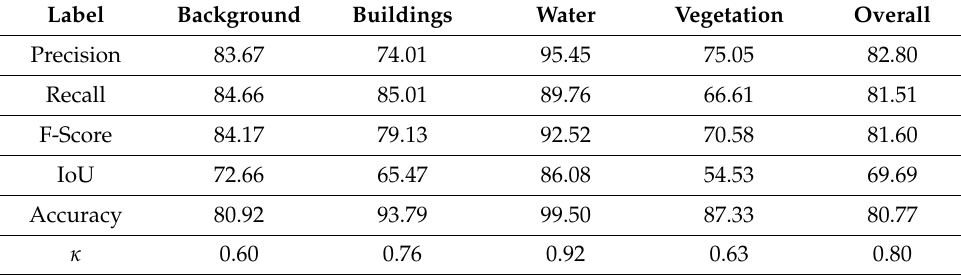
Figure 8. Visual results of our Bayesian U-Net on the Toulouse dataset. Table 4. Accuracy metrics of our Bayesian U-Net on the Toulouse